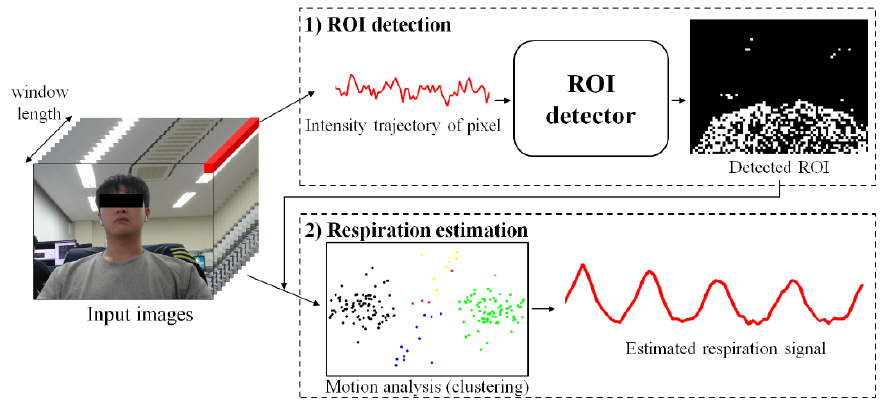
Figure 1. Overall process of the proposed method.